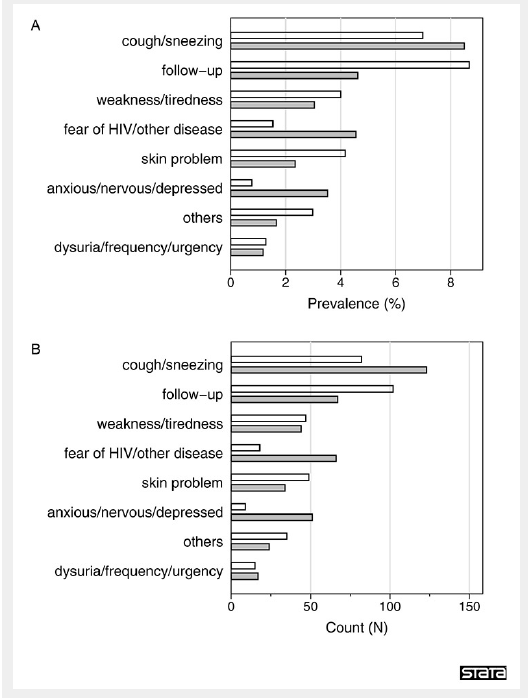
Prevalence rates and counts of “non-urgent” encounters stratified by the observation period. Based on the ICPC-2 codes, we defined “non-urgent” encounters and categorised them as presented. The prevalence rates (panel A) and counts (panel B) are provided separately for the observation period 1 January to 31 January 2008, inclusive (white bars), and 1 January to 31 January 2009, inclusive (grey